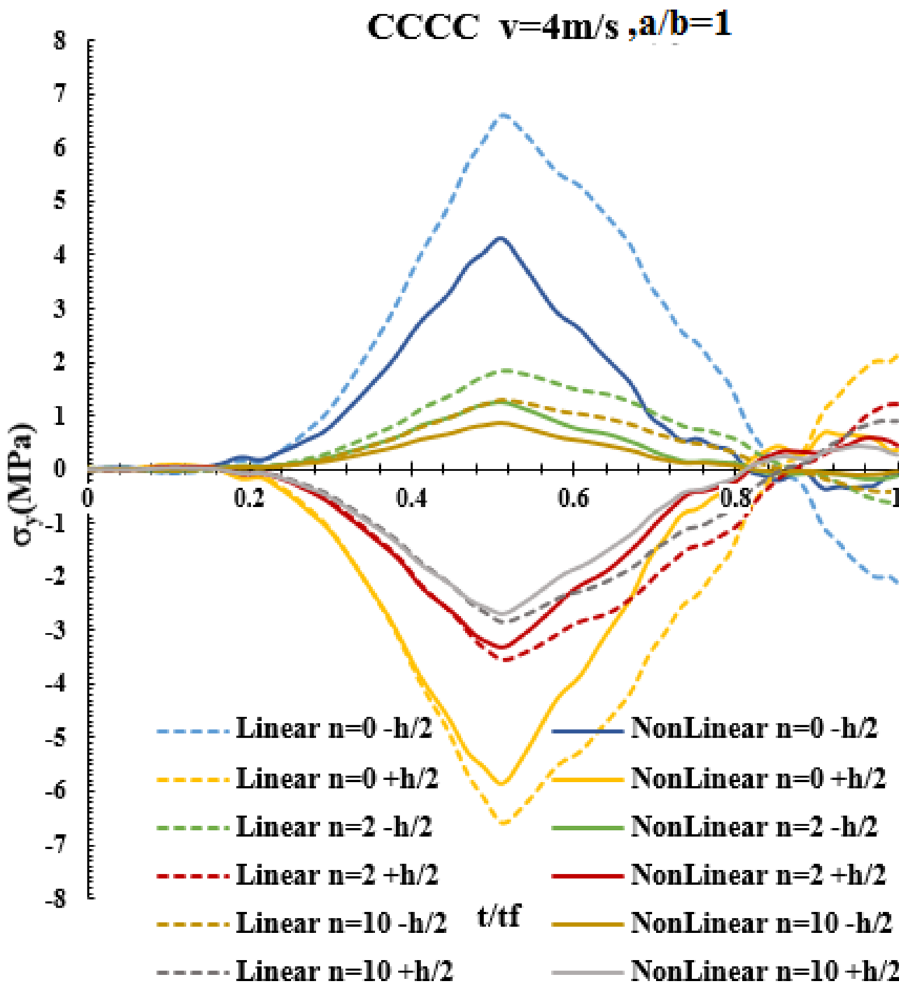
Fig. 23 The effect of material gradient index on transient dis- tribution of 𝜎 yy for center-point of the plate (CCCC, v = 4